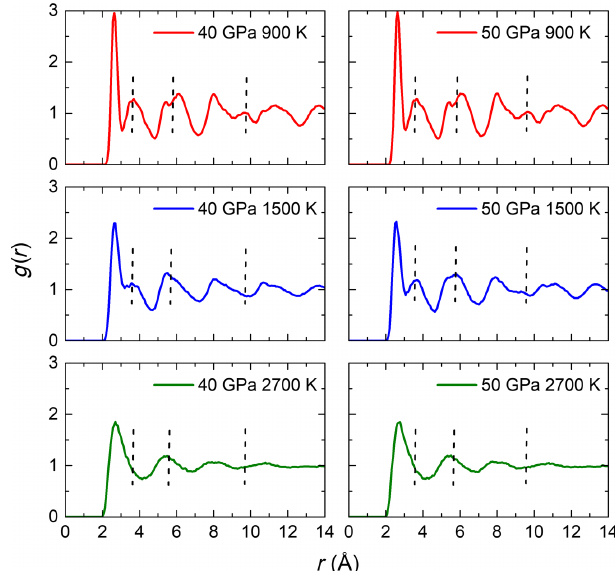
FIG. 3. Pair distribution function g ð r Þ of the AIMD simulations at 40 and 50 GPa and different temperatures. Red, blue, and green lines represent g ð r Þ of simulations at 900, 1500, and 2700 K, which corresponds to the solid, cooperative diffusion and the liquid state,